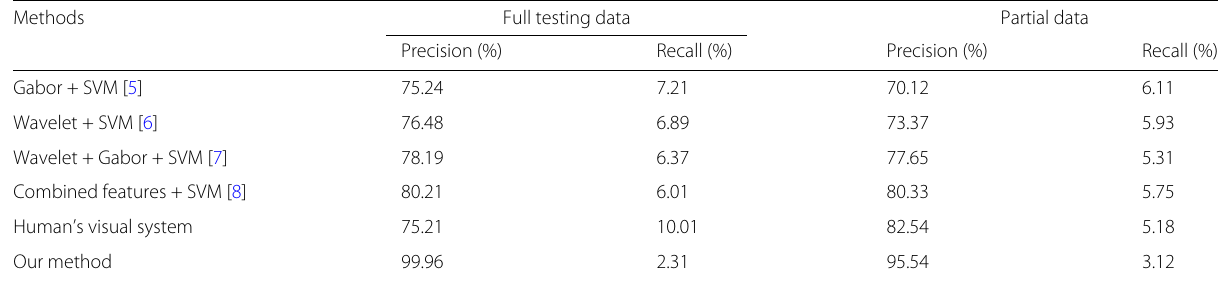
Table 1 The Precision and Recall of SVM methods, human’s visual system, and our method